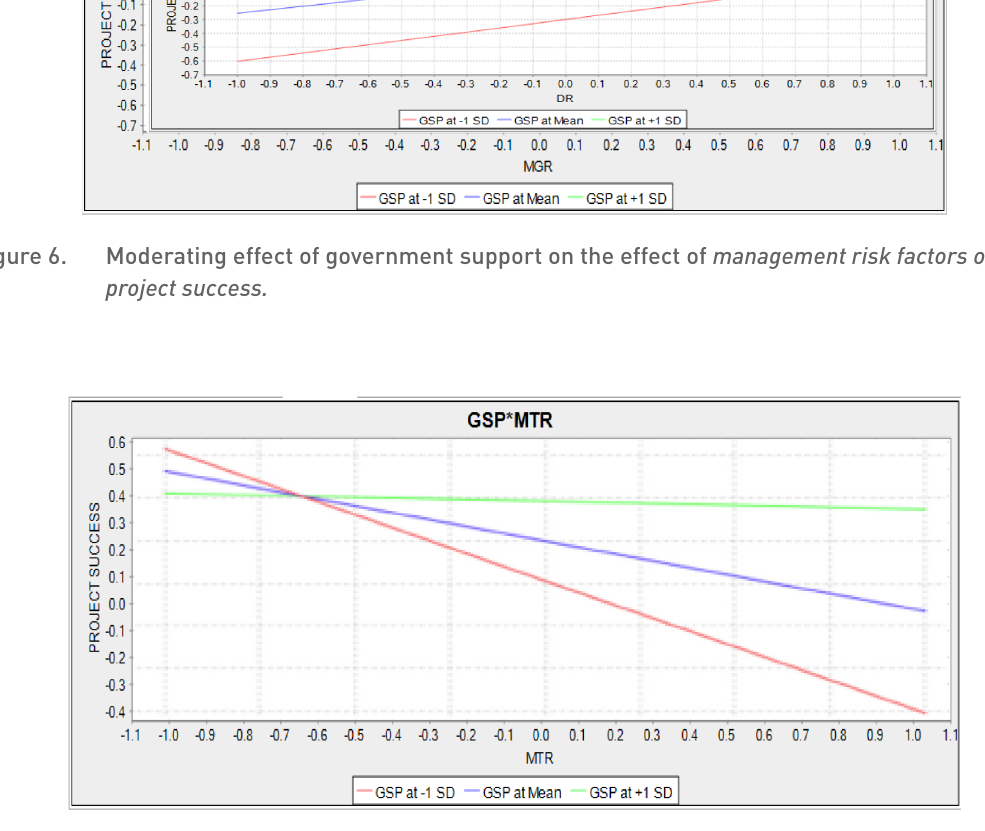
Figure 7. Moderating effect of government support on the effect of material risk factors on project